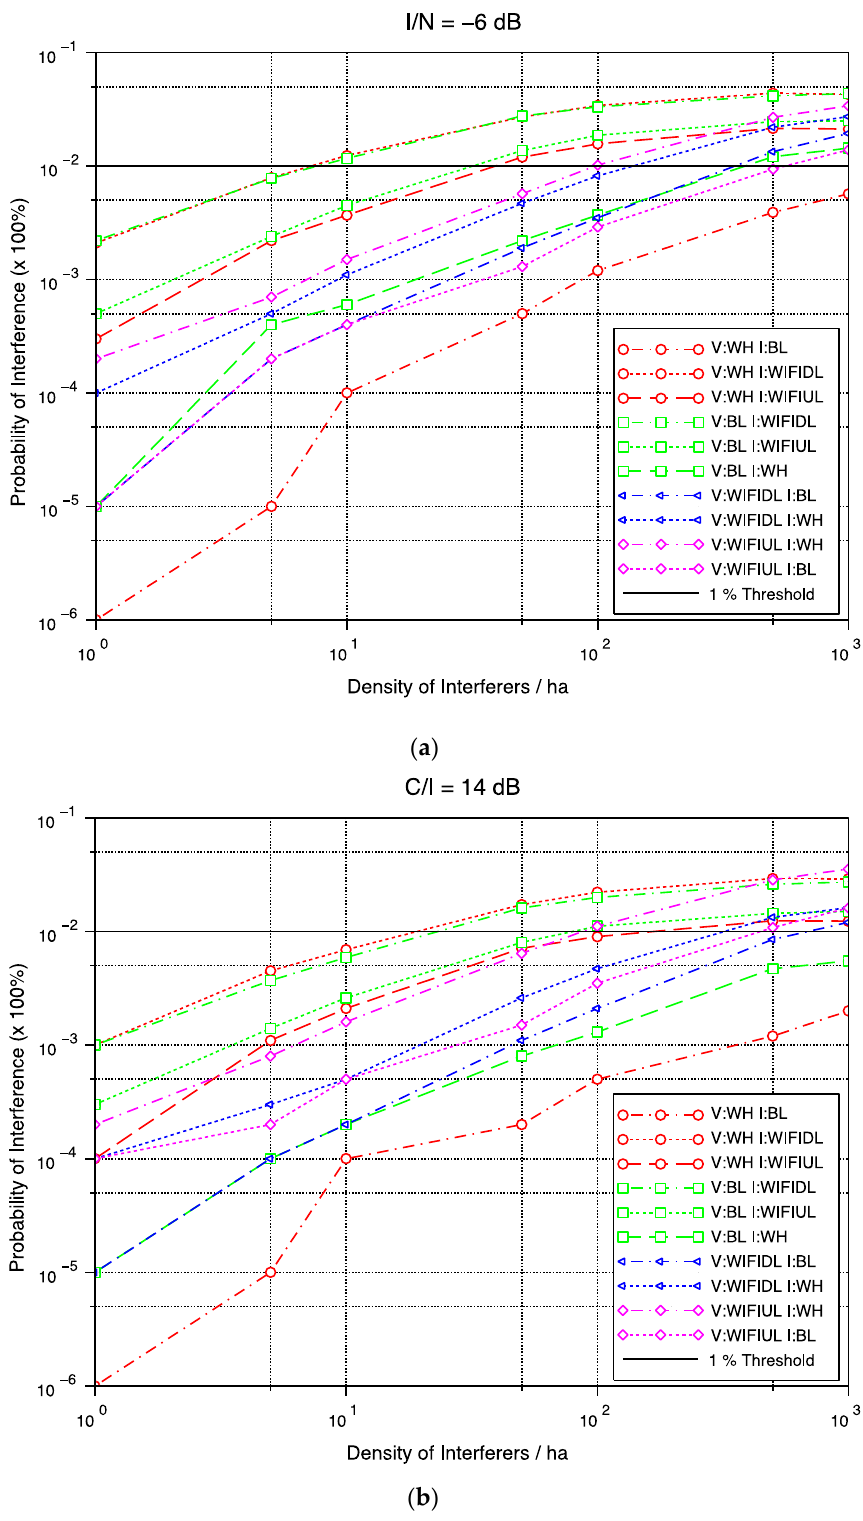
Figure 11. Probability of interference for 10 different scenarios as a function of the density of the interfering transmitters: ( a ) I / N = − 6 dB; and ( b ) C/I = 14 dB. The black horizontal line represents the limit of 1% probability of interference. Table 2. The maximum number of interferers on the factory shop floor for a 1% probability of inter- ference.